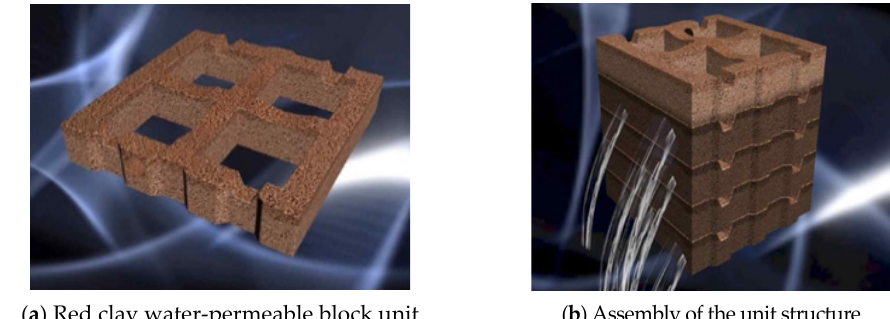
Figure 4. Red clay water-permeable block unit and unit structure.